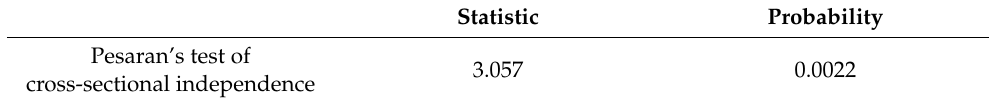
Table 3. The empirical results of Pesaran’s test of cross-sectional